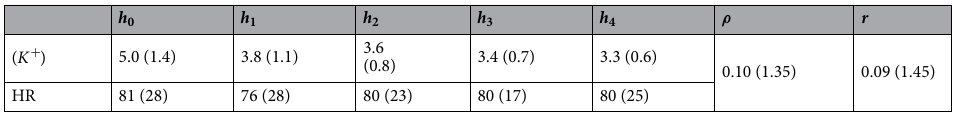
Table 2. Blood potassium concentration [ K + ] values (in mmol/L) at each blood extraction during the HD ( h 0 to h 4 ) and HR (beats/min). Spearman’s ( ρ ) and Pearson’s ( r ) intra-patient correlation coefficients between [ K + ] and RR. Values are expressed as median